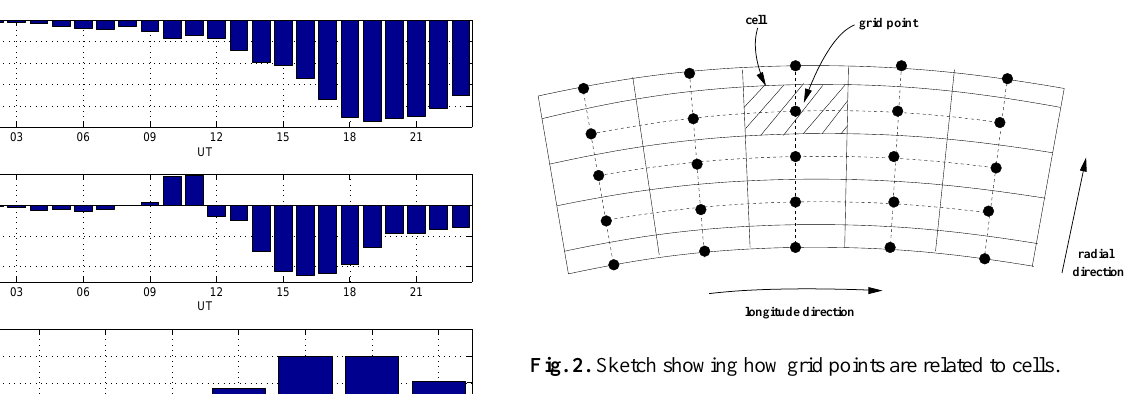
UT Fig. 31. Hourly measurements for D st and B z , and three-hourly measurements for Ap (see (OMNIWeb, access: July 2010) and the